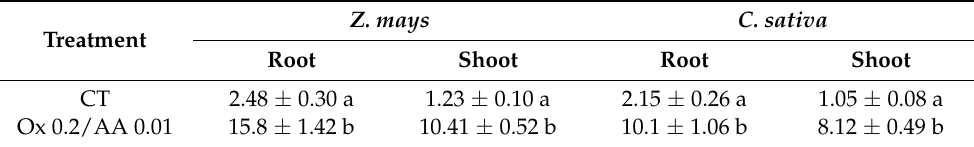
Figure 6. Arsenic uptake by ( a ) roots and ( b ) shoots of Z. mays and C. sativa grown on soil controls (CT) and soils treated with the 0.2 M oxalate and 0.01 M ascorbic acid solution (mesocosm tests).